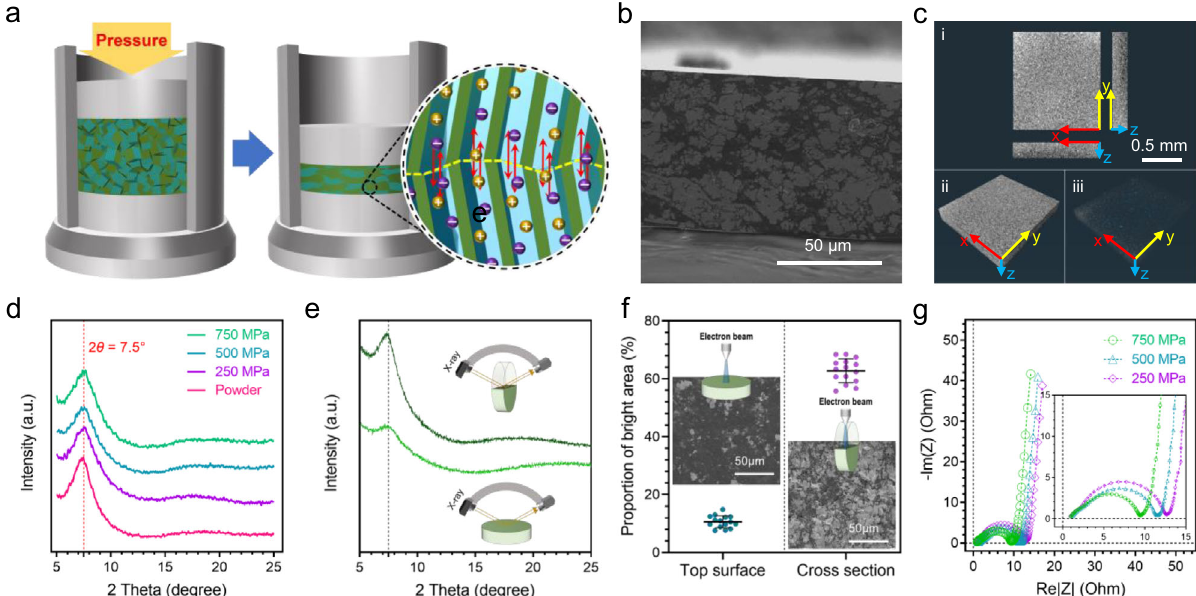
Fig. 2 The uniformly distributed ion penetration network throughout the pellet. a A schematic illustration of the mechanical compaction of TALP particles with the resulting inter-particle connectivity of nano fl uidic ion channels. b The SEM image of the cross-sectional surface of a TALP pellet. c Micro- CT images of TALP pellet. c -i Top view and cross-section view. c -ii The reconstructed micro-CT image. c -iii The pore structure. d The XRD patterns of TALP powders and pellets fabricated under different pressures, which show the consistent structural features of layered nano fl uidic channels. e The XRD pro fi le collected from the standing and lying TALP pellets. The intensity change of X-ray diffraction is a statistical indicator of the alignment direction of the basal planes of 2D ion channels against the incident X-ray. f The statistical brightness analysis of the SEM images collected from the top surface and cross- sectional surface of the TALP pellets. g Nyquist plots of TALP electrode fabricated at different pressures with 5 mg cm − 2 mass loading. The measurement was conducted in a symmetric solid-state EC cell with a leak-free gel